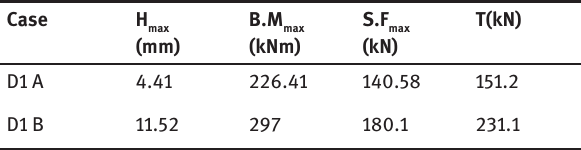
Table 10: Results of analysis with British standards.